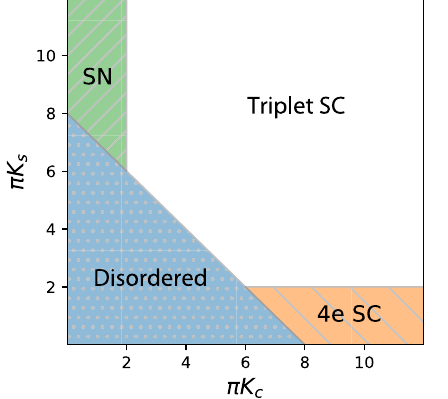
FIG. 11. Temperature dependence of ρ c þ ρ s at QCP for different system sizes and different couplings.